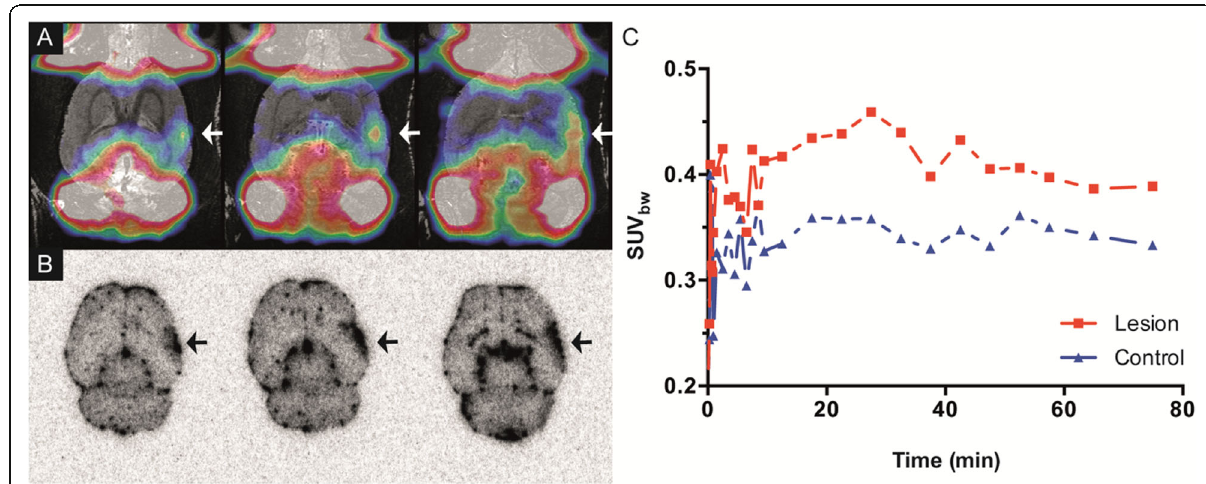
Fig. 8 Increased permeability in the acute phase after an induced focal cortical infarction. a Three successive axial PET images of the uptake of albumin-bound [ 68 Ga]ABY-028-PET in the infarcted (arrowheads) rat brain summed over 0-80 min fused with a magnetic resonance image of a healthy rat. b Ex vivo phosphorimages of corresponding sections from the rat that was imaged with [ 68 Ga]ABY-028. c TACs of radioactivity uptake in the infarcted lesion and the contralateral control